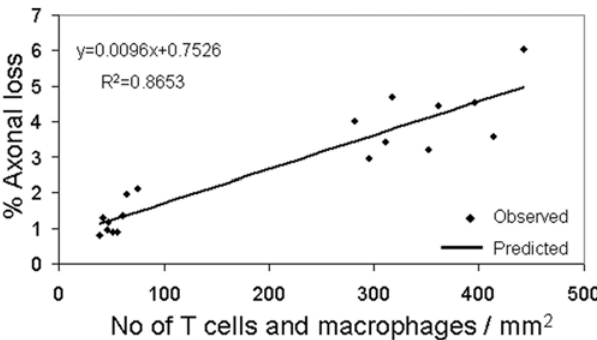
Figure 4. The extent of the inflammatory process strongly correlates with the severity of tissue damage in the acute phase of EAE. NP- transplanted and control mice were sacrificed at 10, 13, 20 and 50 days post EAE induction for pathological analysis of inflammation and tissue damage. Linear-regression analysis of the numbers of inflammatory cells and the extent of axonal loss in both NP- transplanted and control EAE mice at 13 and 20 days post EAE induction showed a strong correlation between the numbers of T cells and macrophages per mm 2 and the percentage of axonal loss.